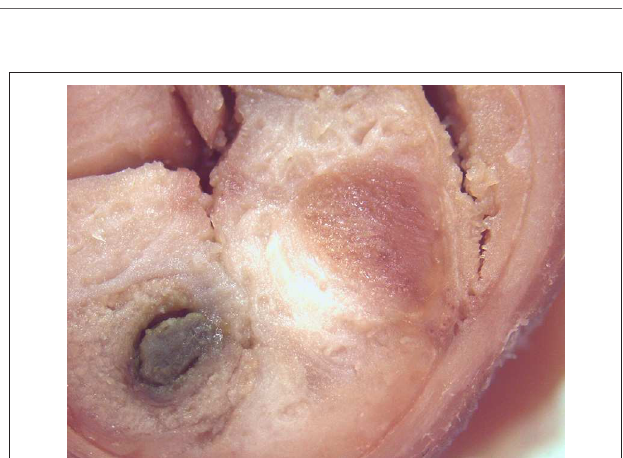
FIGURE 2 | Focal area of degenerated tissue in a PP from a pig fed with the CE diet. Stereomicroscope, hematoxylin-eosin 4 ×